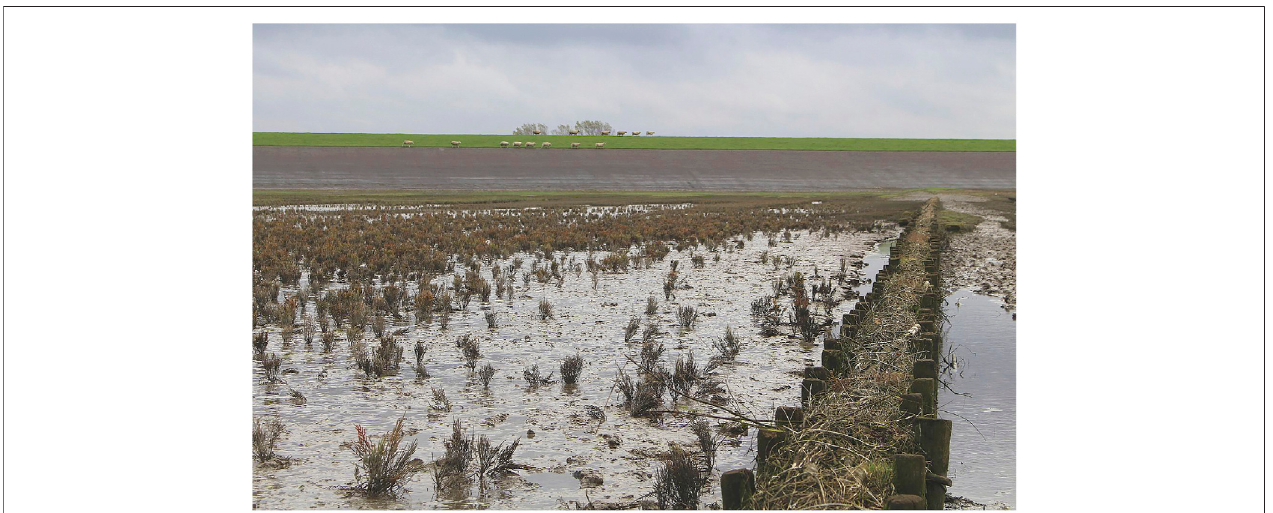
FIGURE12| BrushwooddamsintheDutchWaddenSea,whichcreatearti fi cialshelterforsaltmarshvegetationfromwavesandcurrents.Theleveeisvisibleinthe background (Photo: V. Vuik).